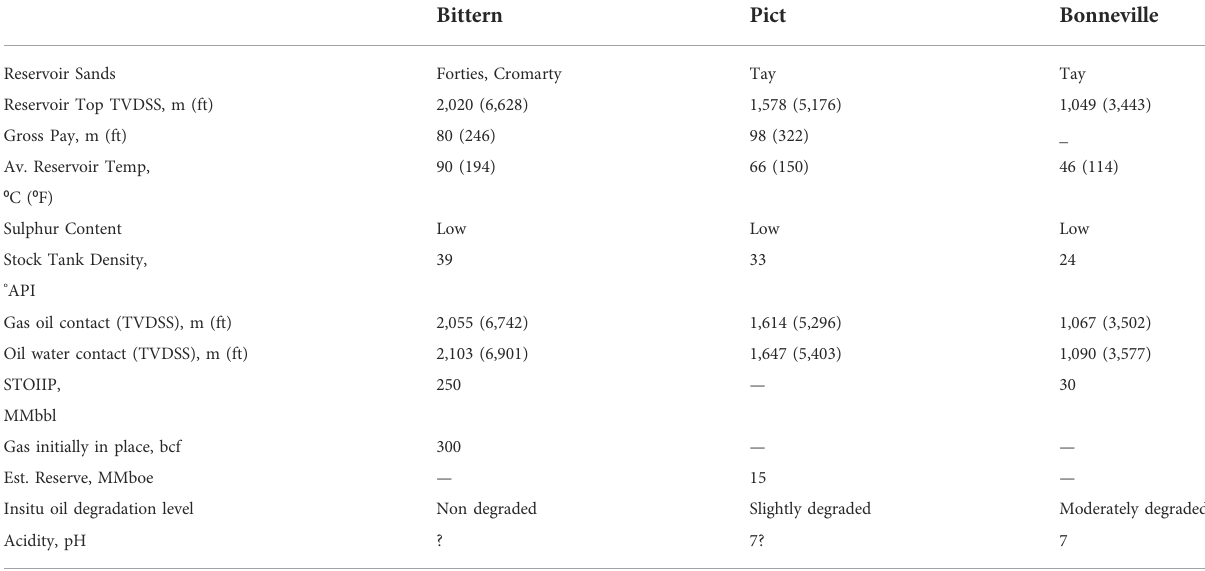
TABLE1Reservoirand fl uidpropertiesofthe fi eldsunderstudy.pHdataisavailablefortheBonneville fi eld.ThepHquotedforPictwasobtainedfrom anearbywellinanadjoiningblock.TherearenopHdatafortheBittern fi eld.MMbbl,bcf,MMboeandTVDSSstandformillionbarrels,billioncubic